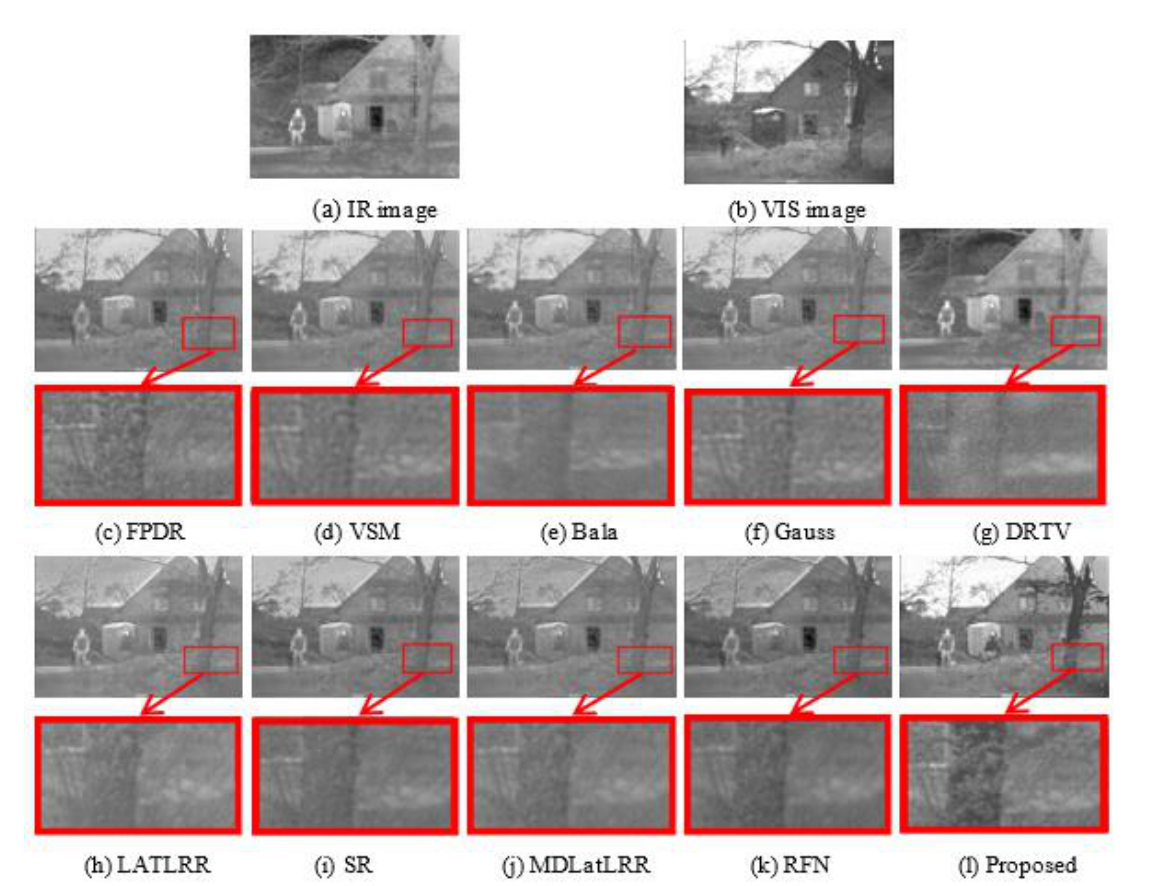
Figure 7. Fusion results on ‘2_Men in front of house’ image. From ( c – l ) are the fusion result of the ten methods.